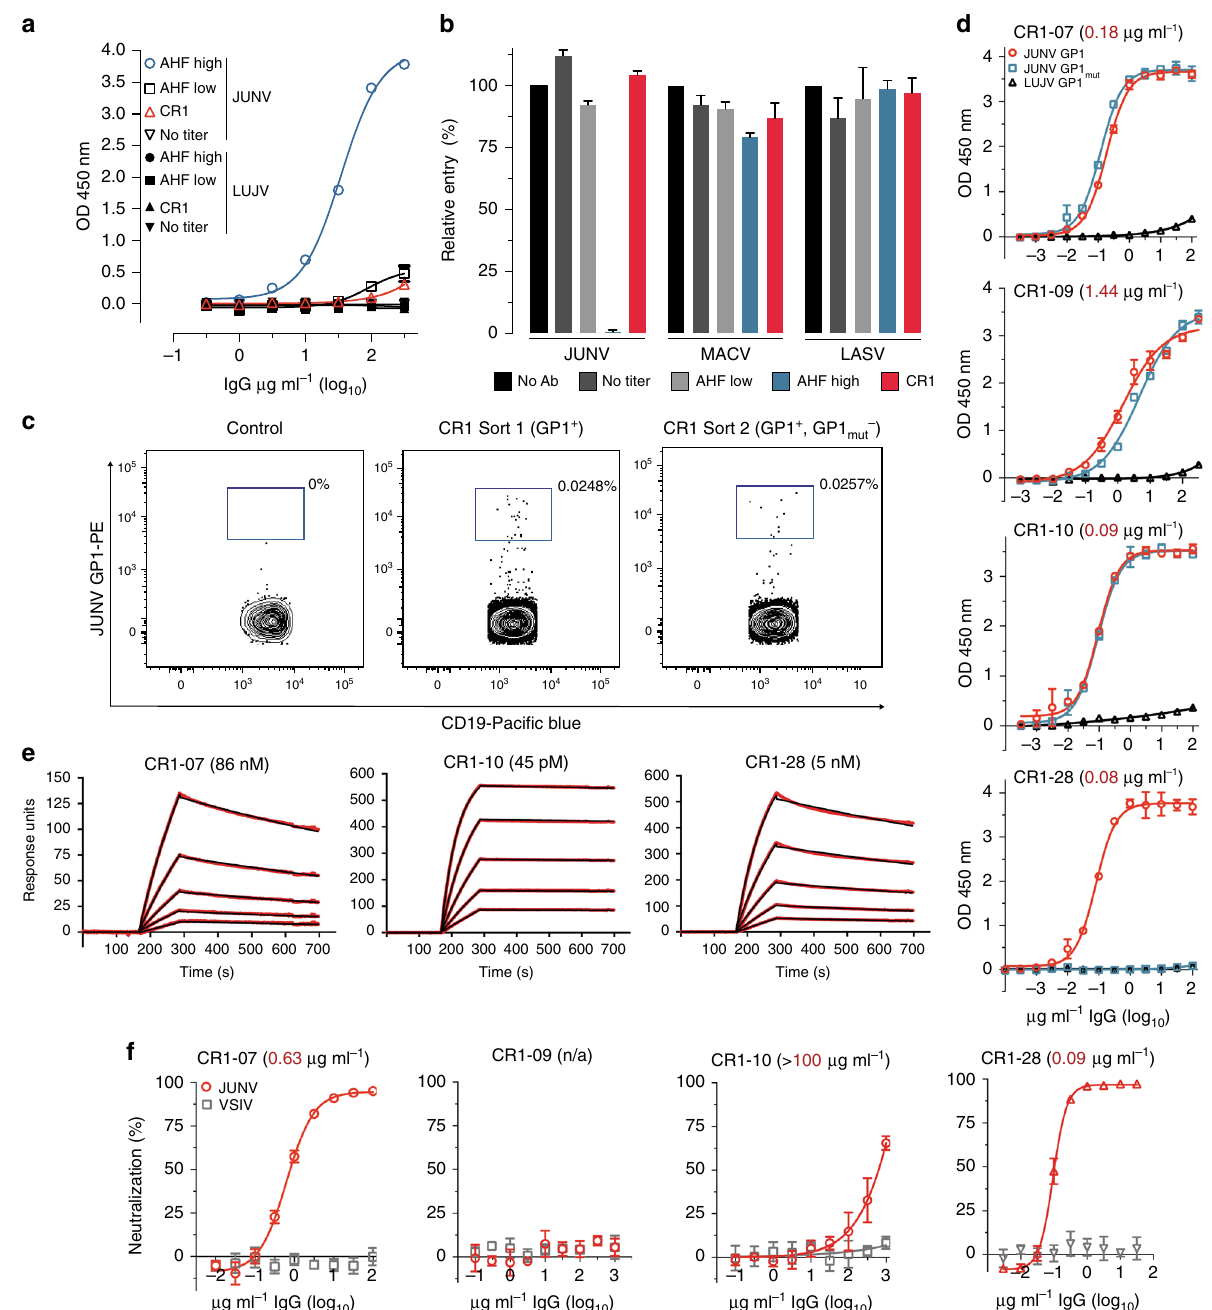
Fig. 1 GP1-reactive monoclonal antibodies from the memory B cells of a Candid #1 recipient. a ELISA of polyclonal IgG puri fi ed from human plasma samples with JUNV GP1-coated plates. “ AHF high ” , “ AHF low ” , and “ No titer ” are AHF survivors pre-determined to have 1:10,240, 1:40, and undetectable neutralizing antibody titers (PRNT 80 ) in their plasma, respectively. CR1: Candid #1 recipient. LUJV GP1 is a control. b HEK293T cells were infected with indicated pseudotypes after pre-incubation with polyclonal IgG (316 µ g ml − 1 ). Entry levels (measured by FACS for GFP) are normalized to a no antibody ( “ No Ab ” ) control. c Representative density plot from a FACS experiment to isolate memory B cells that bind JUNV GP1 PE tetramers (sort 1, middle panel) or JUNV GP1 PE tetramers but not JUNV GP1 mut PerCP tetramers (excluded in a gating step that is not shown) (sort 2, rightmost most panel). The approximate location of the sorting gate is shown as a box, and the percentage of cells that fall within the gate is indicated. The leftmost panel is for a control donor using the sort 1 strategy. CD19 is a B-cell marker. d ELISA of the indicated monoclonal antibodies binding to immobilized JUNV GP1 or JUNV GP1 mut . LUJV GP1 is as a control. The calculated EC 50 values for antibody binding to WT JUNV GP1 are indicated in parentheses. e Sensorgrams for binding of Fabs to immobilized JUNV GP1 as measured by surface plasmon resonance. The recorded sensorgrams (one of duplicates) are shown. Calculated K D values are in parentheses. f HEK293T cells were challenged with JUNV pseudotype after pre-incubation with monoclonal antibodies. IC 50 values are in parentheses. VSIV: vesicular stomatitis virus. For pseudotype neutralization studies, data are averaged from two independent experiments performed in duplicate. For ELISAs, the experiment was performed twice in duplicate and representative data are shown. Error bars indicate standard deviation (S.D.). For some data points, error bars are smaller than